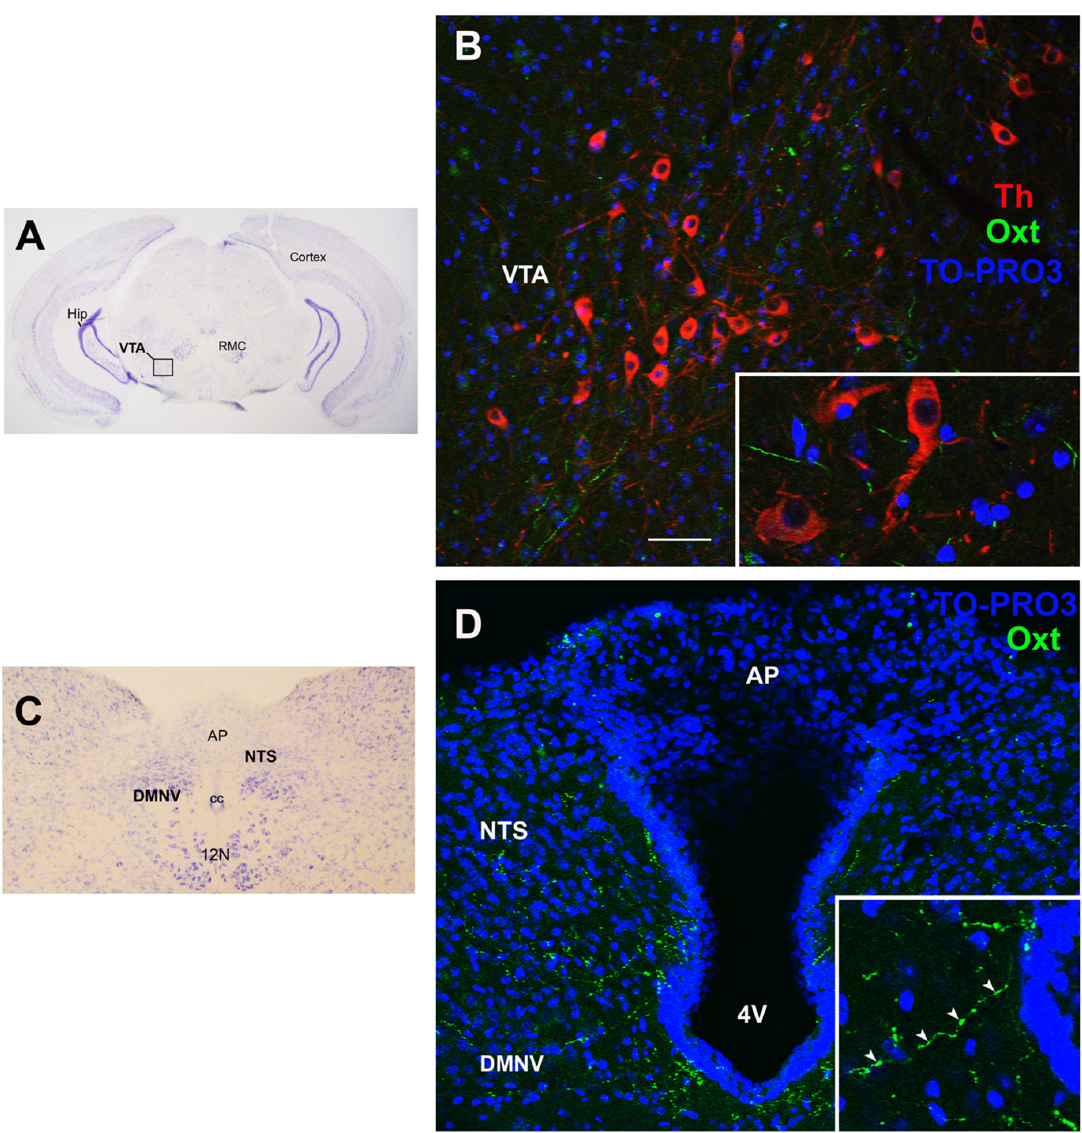
Figure 4. Oxytocin projections in the ventral tegmental area and in the dorsovagal complex. ( A ) Light microscopy (LM): Nissl-stained brain coronal section of the region corresponding to bregma − 3.52 mm, where the ventral tegmental area (VTA; framed) is located, in proximity of the red magnocellular nuclei (RMC); Hip: hippocampus. ( B ) Triple-labeled confocal microscopy (CM) of oxytocinergic (Oxt) fibers scattered between dopaminergic tyrosine hydroxylase (Th)-positive VTA neurons. Inset: higher magnification of Th-positive neurons surrounded by Oxt fibers. ( C ) LM: Nissl-stained brain coronal section of the brainstem at bregma − 7.32 mm showing the area postrema (AP), NTS, and dorsomotor nucleus of the vagus nerve (DMNV), which together form the dorsovagal complex (DMC), a critical structure for energy balance regulation; cc, central canal; 12N: hypoglossal nucleus. ( D ) Double-staining CM: Oxt projections in the DMC. Inset: Oxt fibers in the DMC at higher magnification. 4V: fourth ventricle. Cell nuclei (blue) are marked using TO-PRO3 staining. All figures refer to a 6-month-old male C57BL/6 mouse. Bregma reference sections from “The Mouse Brain Atlas”, Paxinos and Franklin (2001). The scale bar is only specified in ( C ) and corresponds to different μ m in each figure, as follows: in ( A ): 2500 μ m; in ( B ): 50 μ m; inset 20 μ m; in ( C ): 400 μ m; in ( D ): 45 μ m; inset 20 μ m. All figures are original. Methodological details are available in the Supplementary Materials S1.